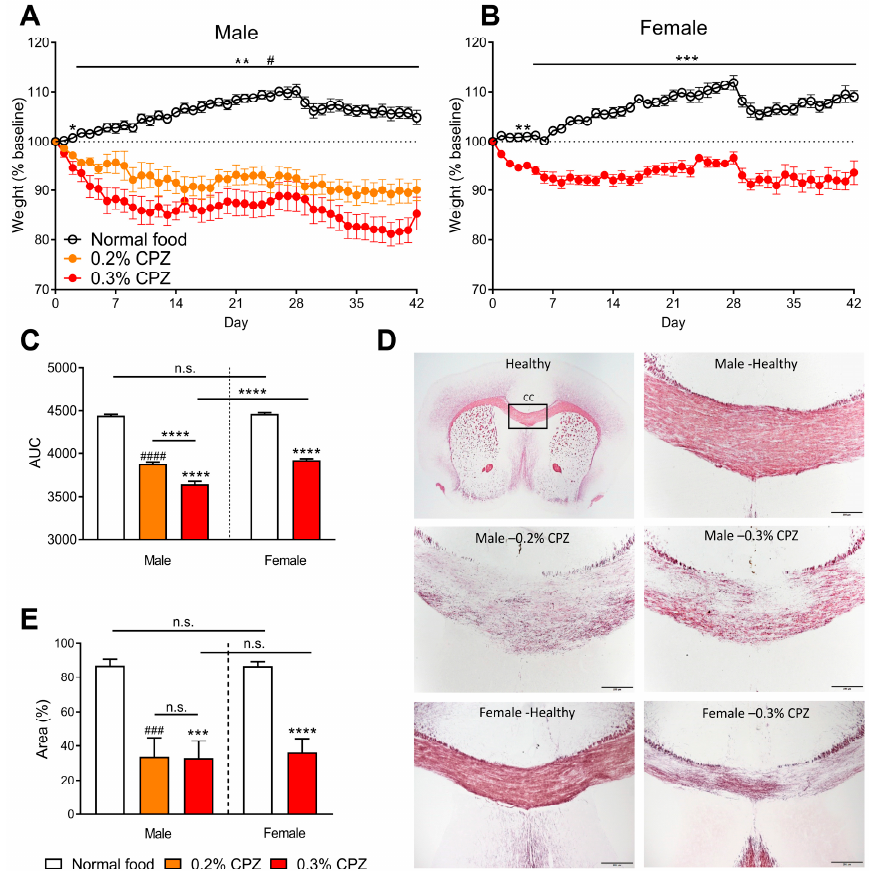
Figure 1. Cuprizone administration led to weight loss and demyelination in male and female C57BL/6J mice. The body weight of the mice was measured daily over the 42 days of cuprizone (CPZ) administration. ( A ) Male and ( B ) female mice administered cuprizone lost weight compared to the normal food diet, n = 8–10. ( C ) Area under the curve (AUC) analysis showed that all groups administered cuprizone lost weight, with the 0.3% cuprizone treatment in males showing more severe weight loss than the 0.2% dose in males and the 0.3% dose in females. ( D ) Representative images showing Black gold II myelin stain taken from day 42 of cuprizone administration. ( E ) Threshold analysis gave the percentage of area stained within a region of interest positioned at the midline of the corpus callosum (CC). In the male and female animals treated with cuprizone, there was a reduction in the area of myelin stained compared to mice given normal food. Analysed in 3–4 sections per animal (averaged), n = 5–10. The scale bar is 200 µ m. # p < 0.05, ### p < 0.001, #### p < 0.0001 for 0.2% cuprizone vs. normal food. * p < 0.05, ** p < 0.01, *** p < 0.001, **** p < 0.0001 for 0.3% cuprizone vs. normal food, or as indicated. n.s. = not significant. Data presented as mean ±